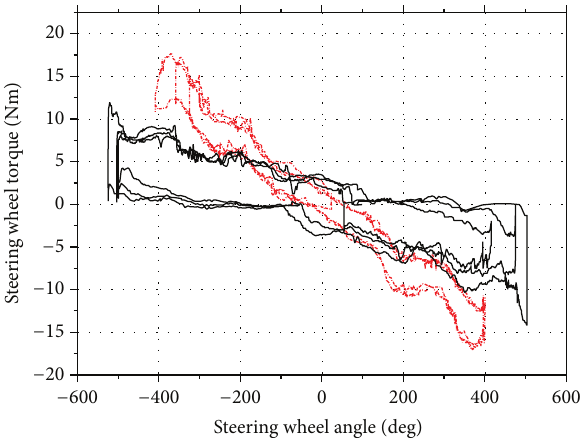
Figure 10: Motor current in the